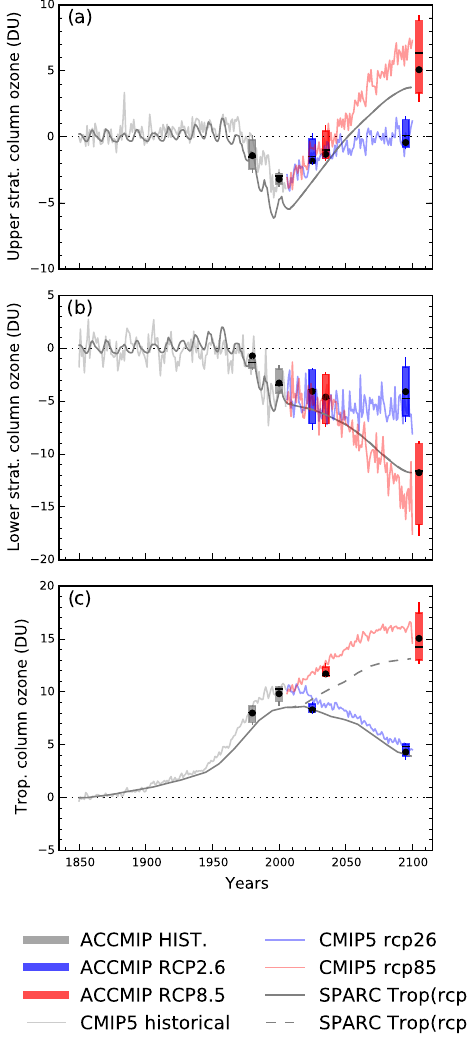
Figure 4. As Fig. 3, but for the upper stratosphere (10–1hPa), lower stratosphere ( > 15hPa), and tropospheric columns ozone (DU) in the